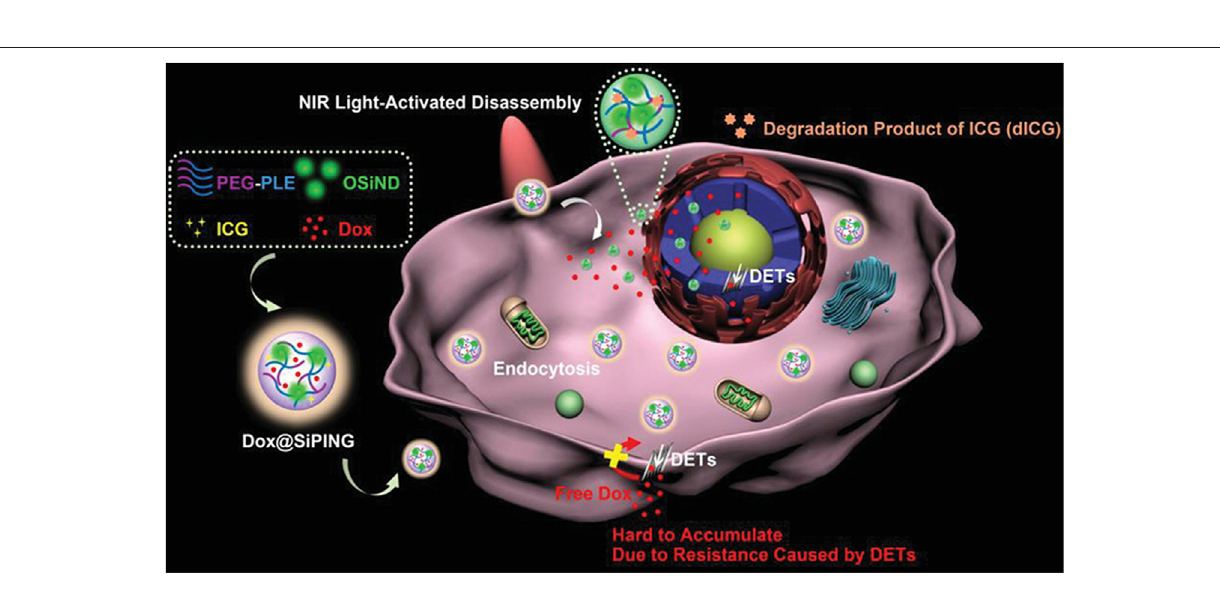
Frontiers in Pharmacology |